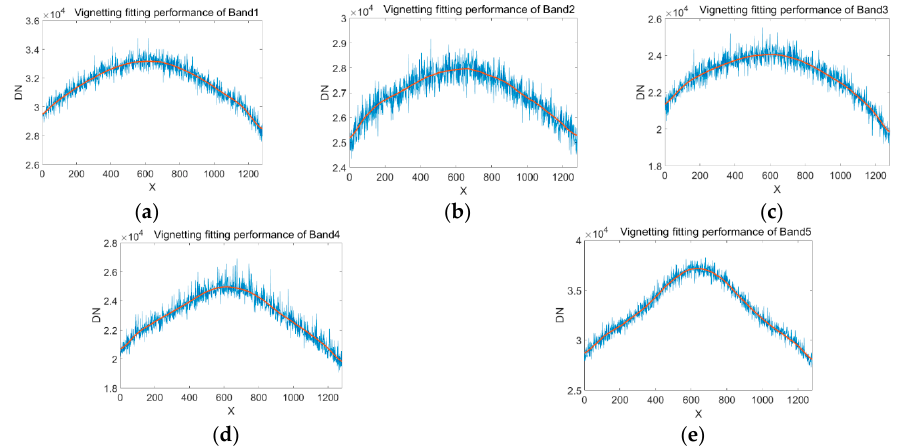
Figure 11. Comparison of middle row pixels between vignetting image and original image: ( a ) fitting